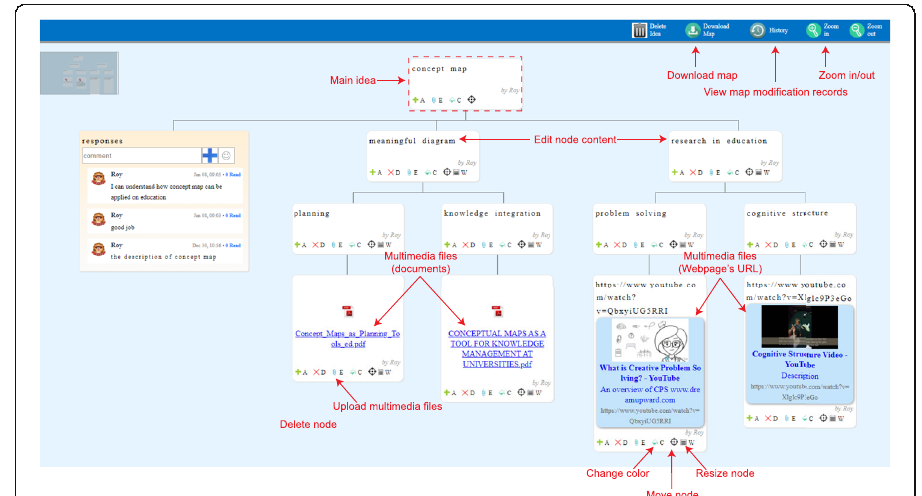
Fig. 3 Concept map construction tool